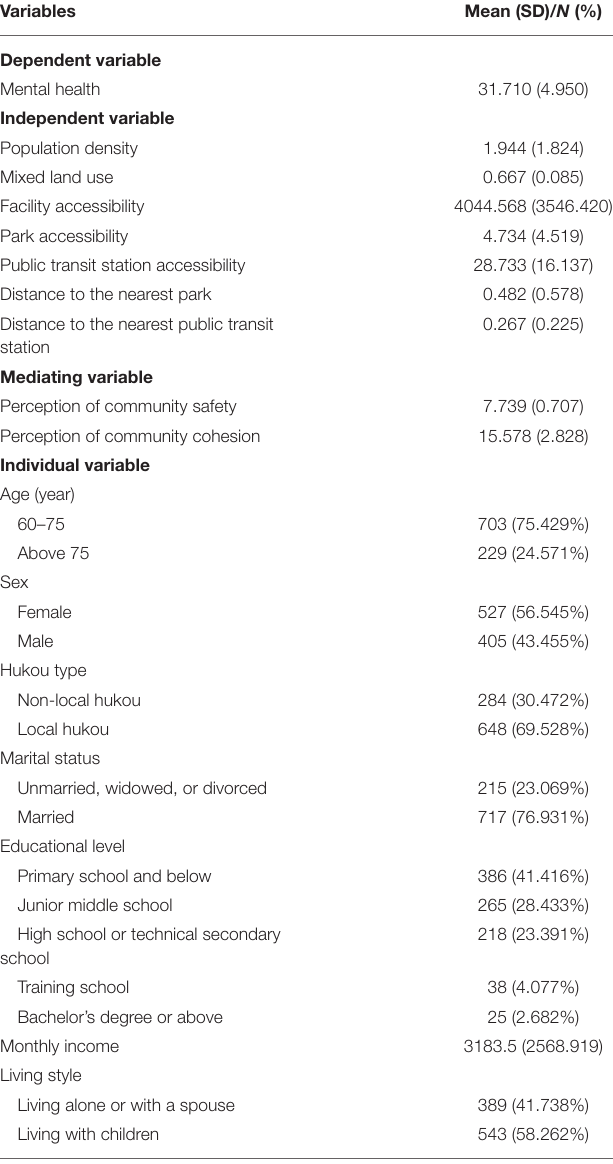
TABLE 3 | Summary statistics for all